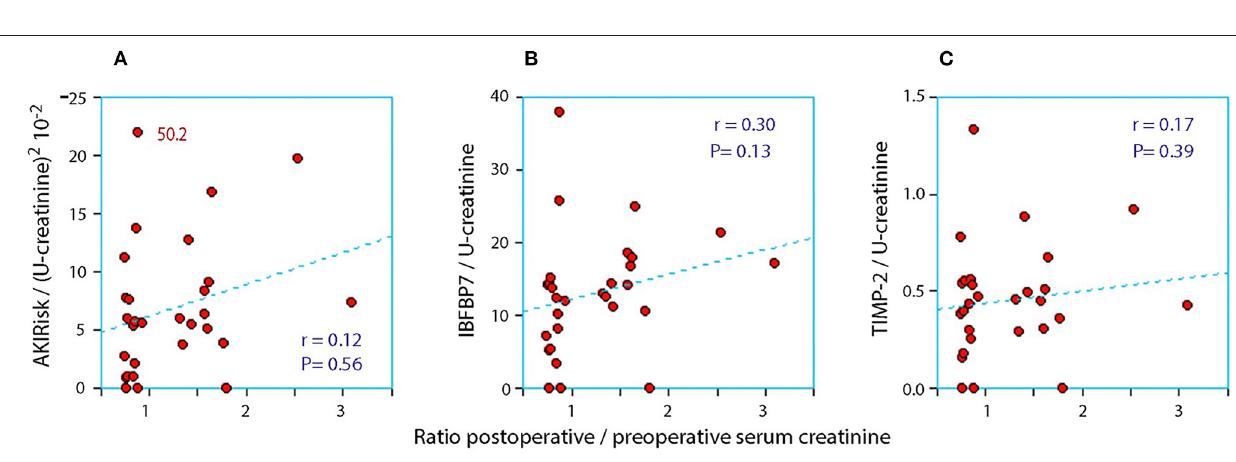
FIGURE 2 | The relationship between the perioperative relative change in serum creatinine and the postoperative urinary concentration of (A) AKIRisk TM , (B) IGFBP7, and (C) TIMP-2. The two biomarkers were corrected for sample dilution while the product, AKIRisk TM , was corrected by the square of the sample dilution. An extreme outlier at 50.2 on the y-axis of in subplot SA has been moved down as